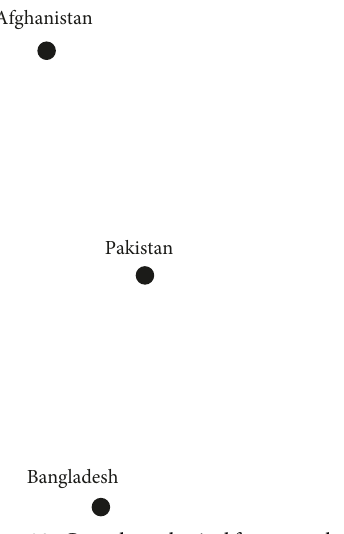
Figure 20: Complex sphericalfuzzy graph with noedge.